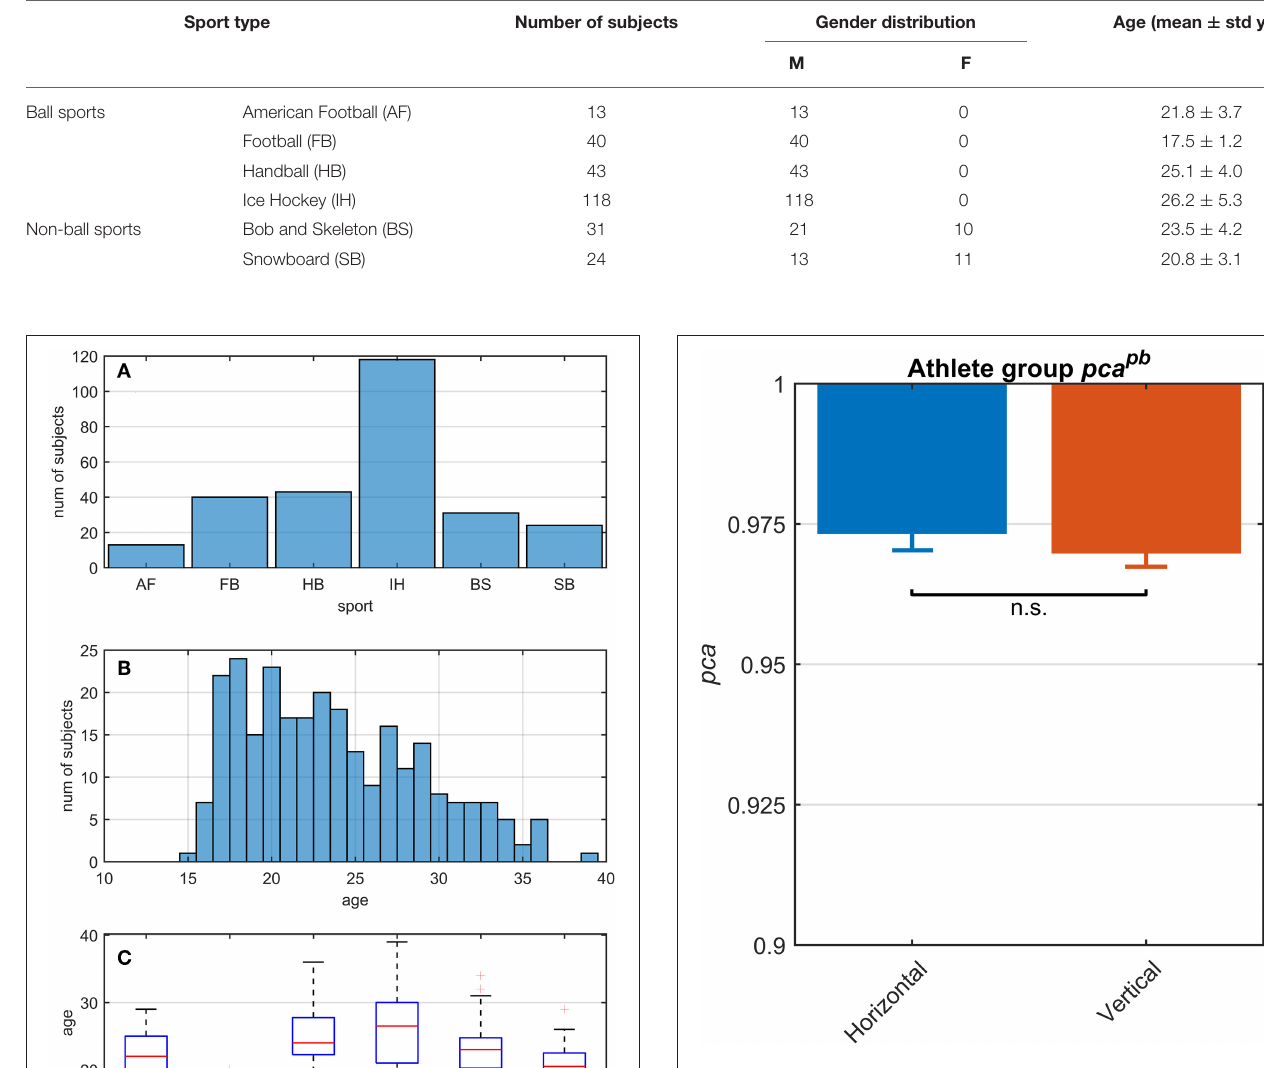
FIGURE 2 | Proportions of correct answers ( pca ) for each vestibular canal in the whole athlete group . Pca of impulses performed in the horizontal (blue) and vertical canals (red) were computed using the pooled approach (Equation 1) considering only head movements in the range of 2,001–6,000 deg/s 2 . Zeta distribution was used to estimate the lower bound of 95% confidence interval for pca, as the number of trials (i.e., performed head movements) was large enough ( >> 200). As visible, the fHIT performance was not significant influenced by canals